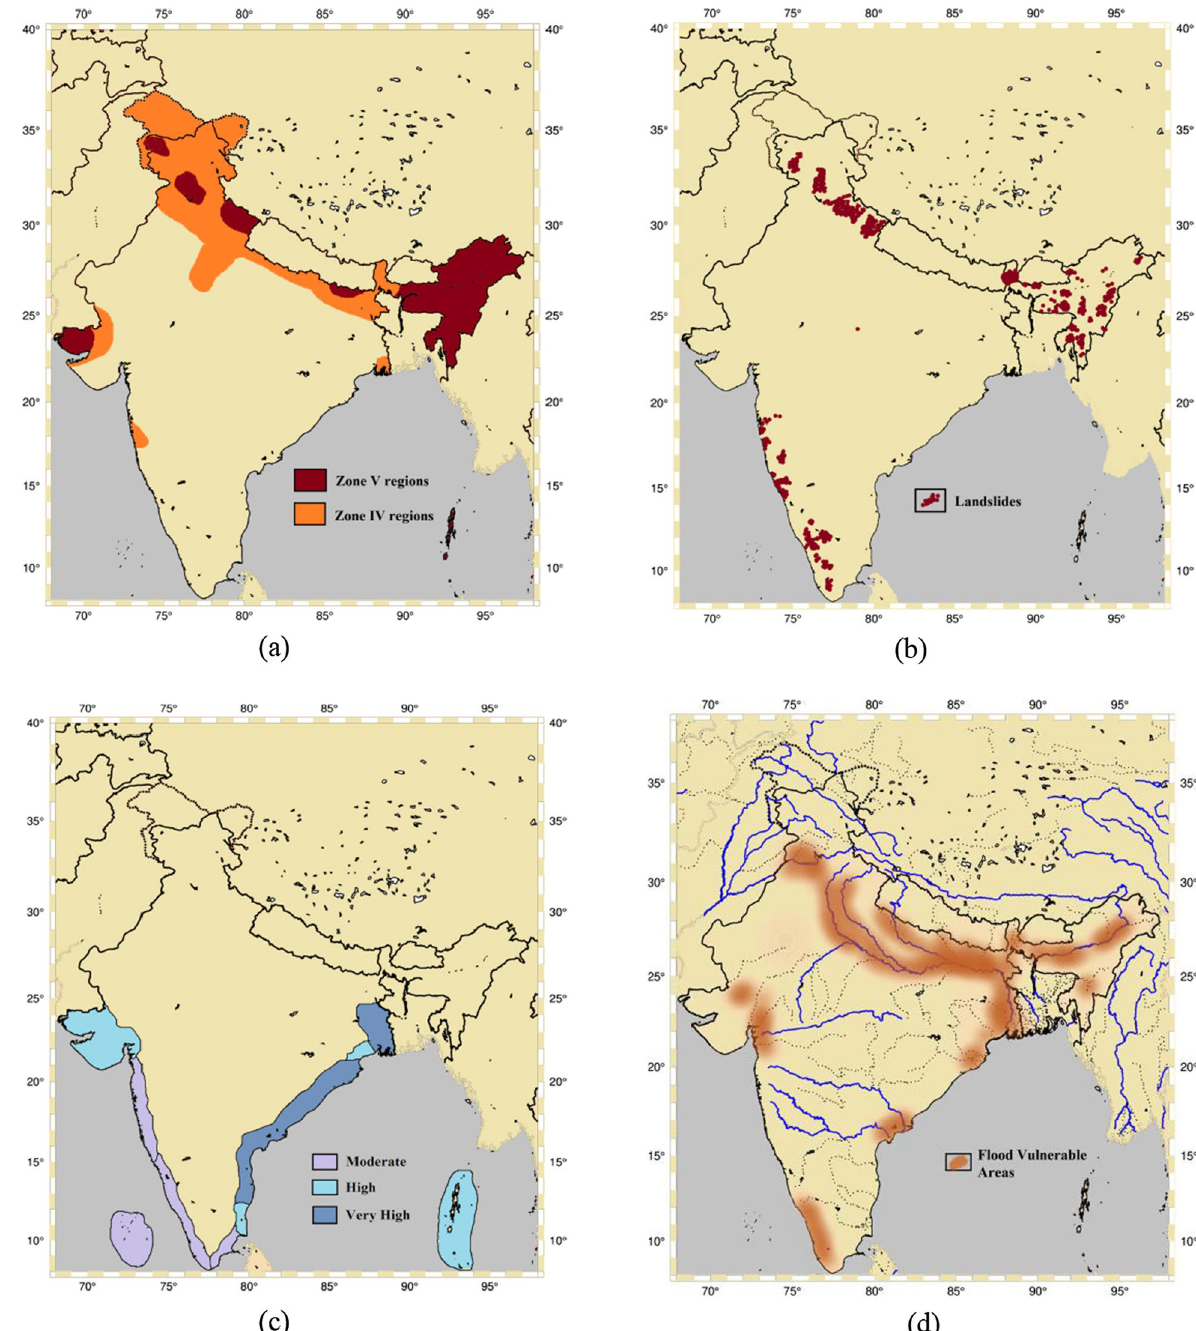
Fig. 4 Color blocks in the images represent only those zones in India which are highly susceptible to major destruction in the event of certain natural calamity (BMTPC 2019). a High-intensity seismic zones. b Regions susceptible to landslides. c Three vulnerable degrees of the cyclones— moderate (63–117 km/hr*), high (118–167 km/hr*), very high (above 168 km/hr*). d Regions vulnerable to floods with deep blue lines showing large rivers. * maximum sustained wind speeds in